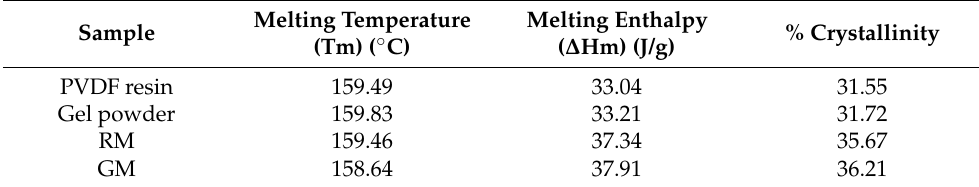
Table 2. Thermal properties of the PVDF samples and